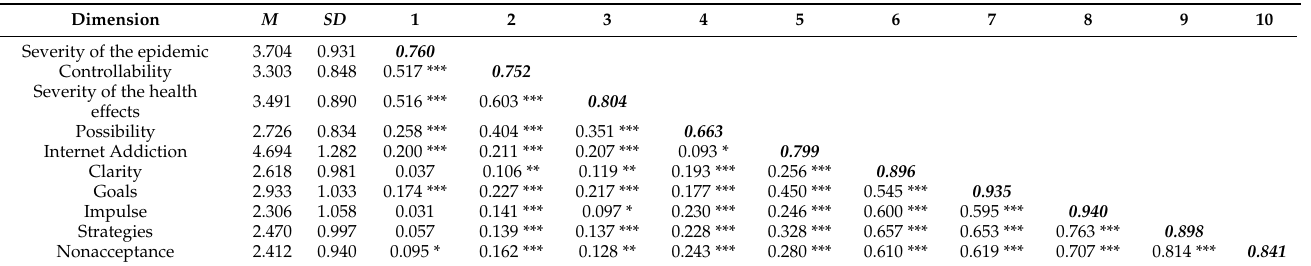
Table 4. Discriminant